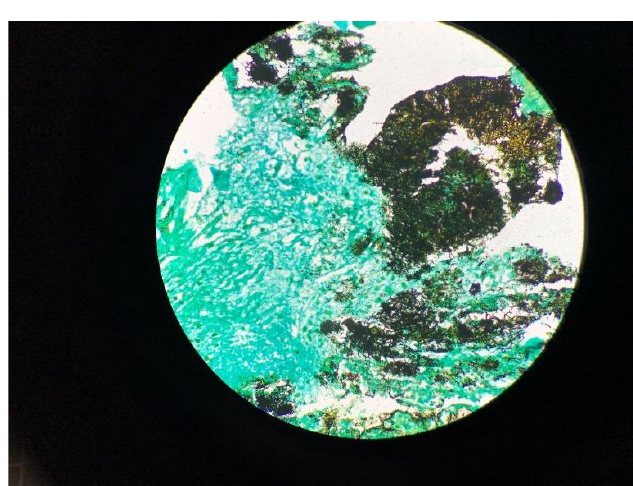
Figure 4. Bronchial biopsy showing actinomycosis with Splendore Hoeppli phenomenon(x20; x40).